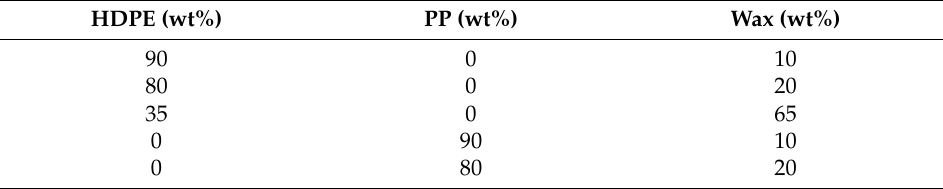
Table 3. Components (polymers and wax) concentrations of blends used for miscibility study. HDPE (wt%) PP